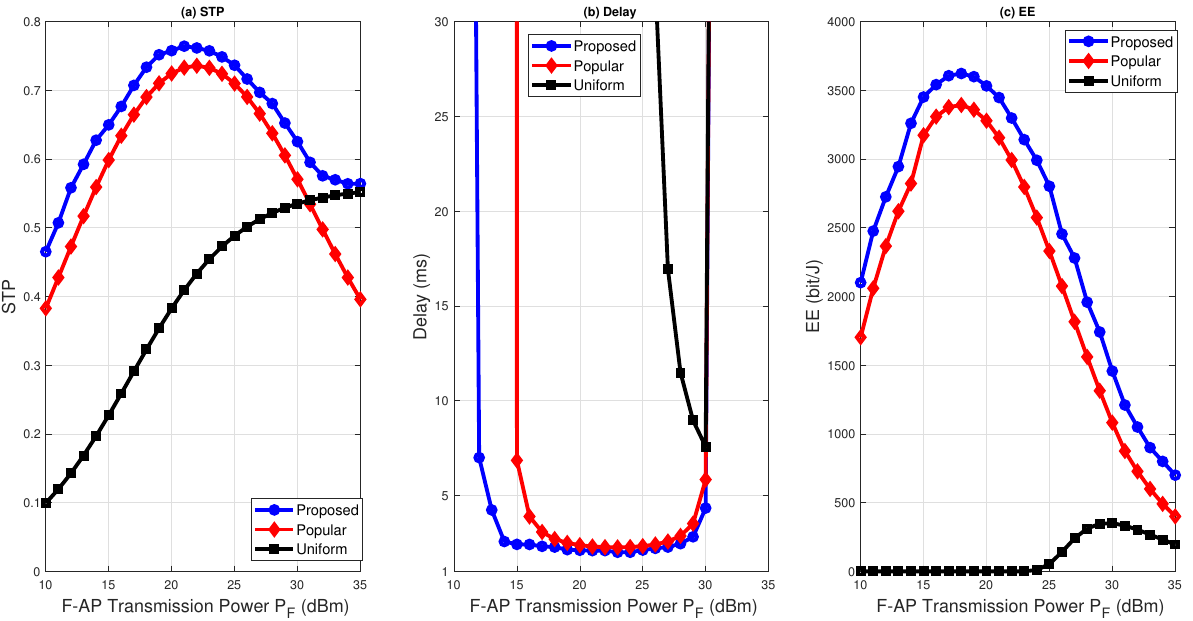
Figure 10. STP, delay, and EE versus F-APs’ transmission power when M = 20 contents, λ U = 0.1 users/m 2 , λ F = 0.01 F-APs/m 2 , λ C = 0.0001 C-APs/m 2 , R = 150 m, γ = 0.8, α = 4, P C = 40 dBm, P s = 37 dBm, ρ = 15.13, W F = 100 MHz, W C = 500 MHz, T = 1 ms, and τ = 0.1